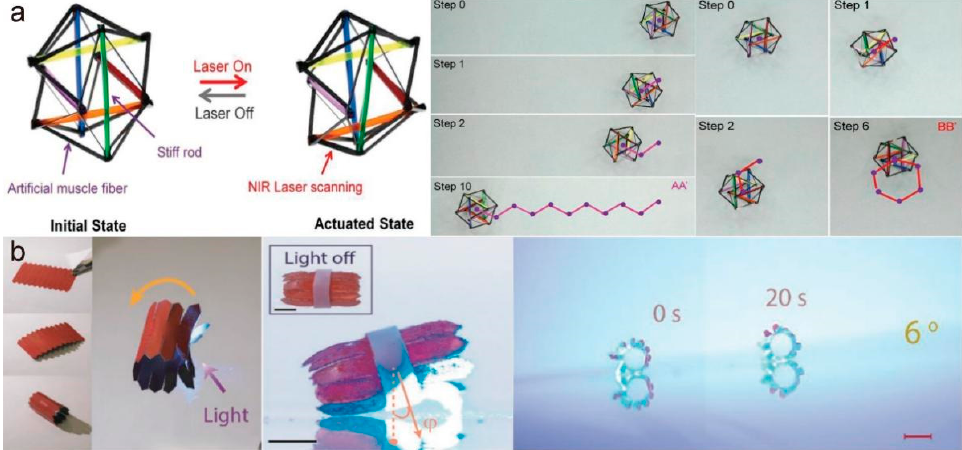
Figure 12. ( a ) Light-induced deformation schematic diagram of a tensegrity robot and demonstration of zigzag and gyro rolling of the robot under irradiation with a NIR laser (Reprinted with permission from Ref. [96]. Copyright 2019, John Wiley and Sons). ( b ) Design of a light-driven rolling robot, and images of the robot climbing a 6° hill (Reprinted with permission from Ref. [97]. Copyright 2020, John Wiley and Sons).